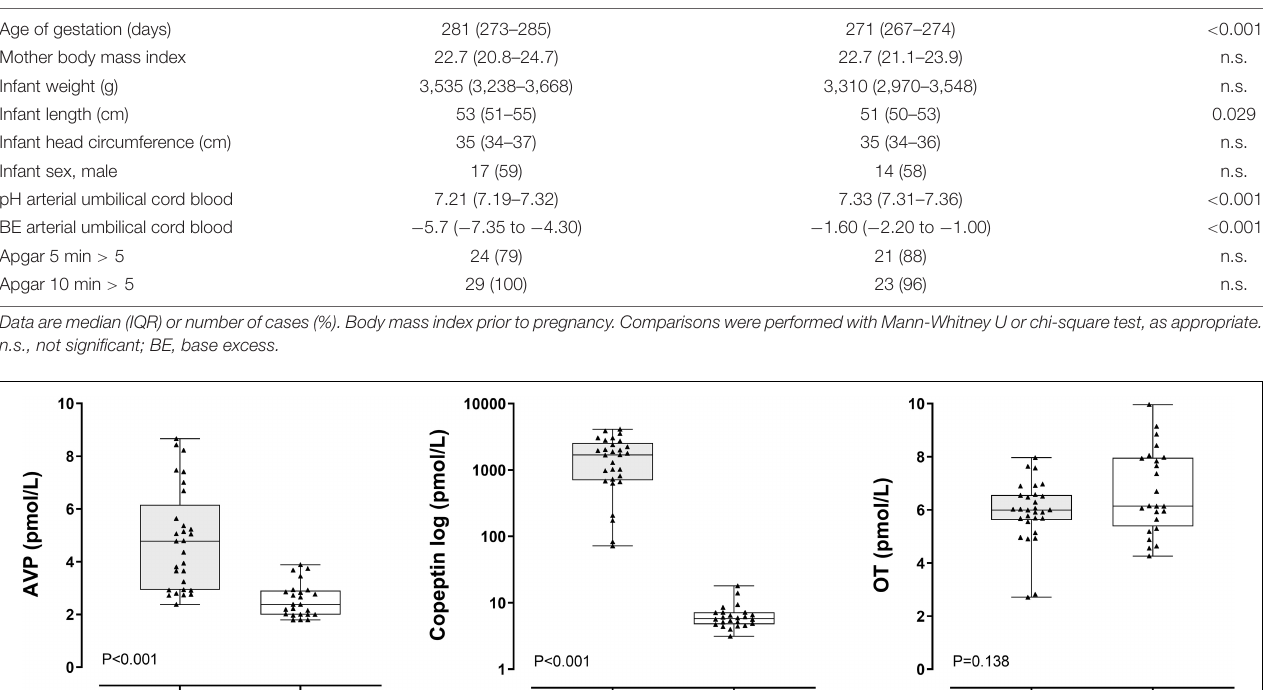
TABLE 1 | Characteristics of mothers and newborns, and pregnancy outcome according to mode of delivery. Vaginal delivery ( n = 29)